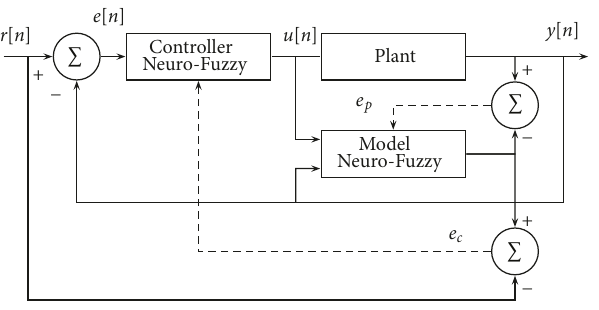
Figure 1: Control using a neurofuzzy system.